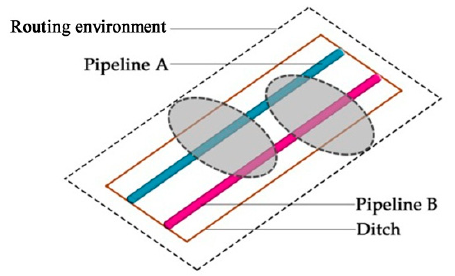
Figure 1. The diagram of the pipelines laid in one ditch (PLOD) system. 98